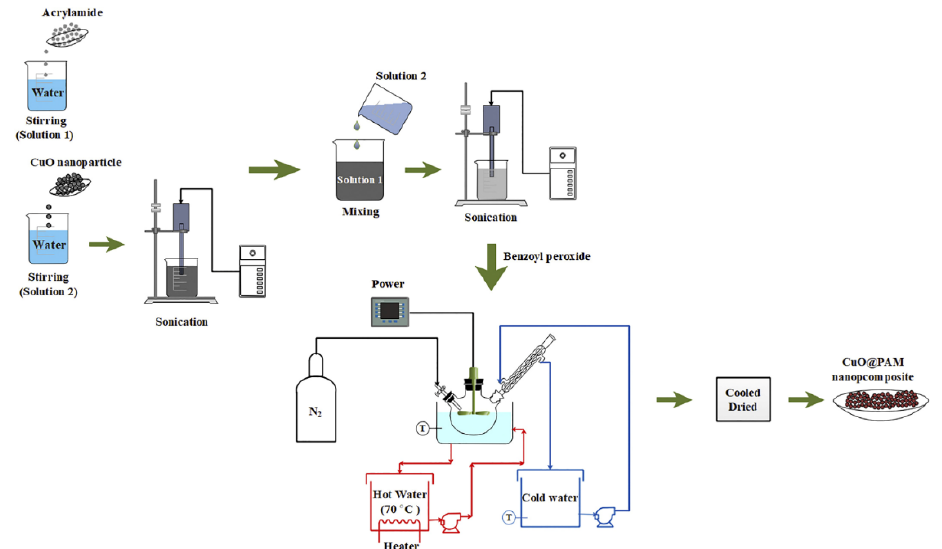
Figure 1. Synthesis of copper oxide/polyacrylamide (CuO/PAM) nanocomposite through the solution polymerization process. Reproduced with permission from [31]. Copyright Elsevier, 2019.